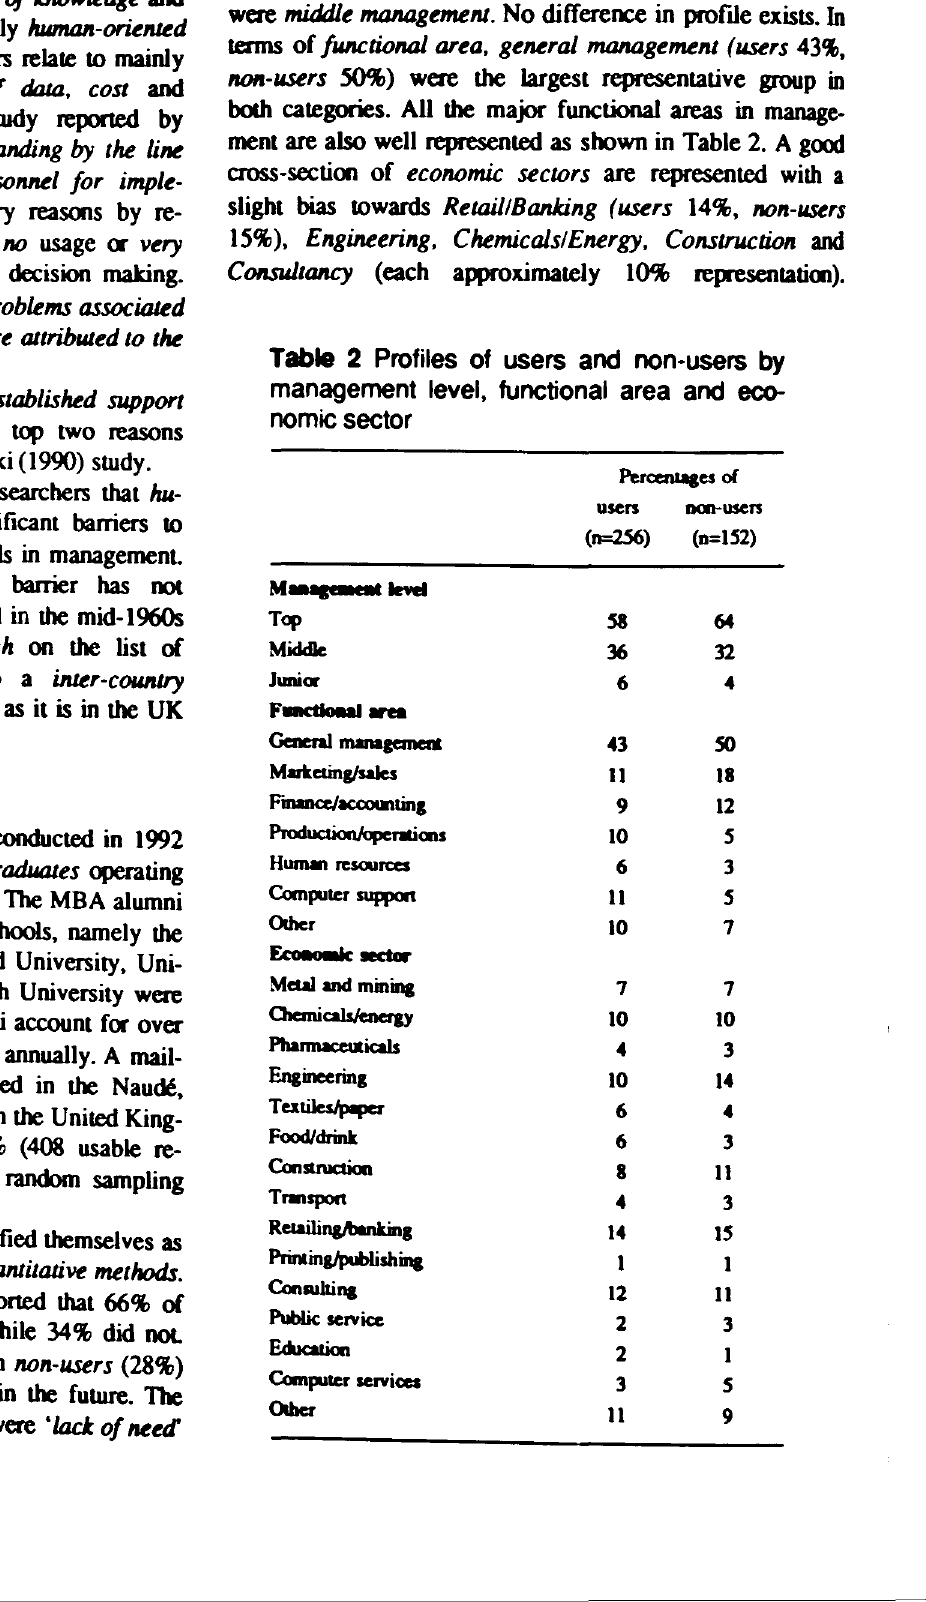
Table 2 Profiles of users and non-users by management level, functional area and